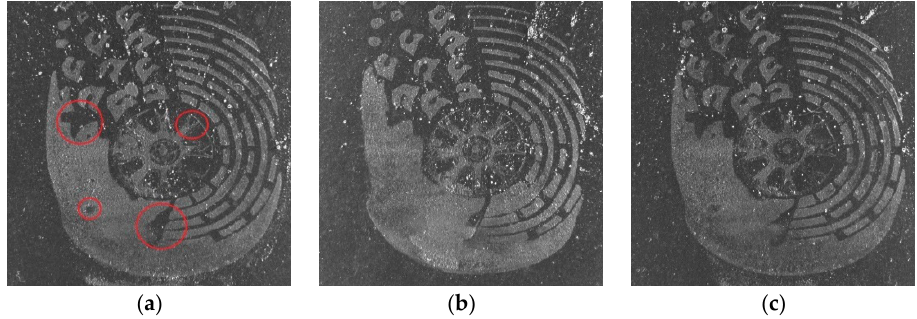
Figure 12. Samples of the probe shoeprint and two questioned shoeprints. ( a ) The probe shoeprint sample; ( b ) the questioned shoeprint sample that is made by different shoes with ( a ); ( c ) the questioned shoeprint sample that is made by the same shoe with ( a ).